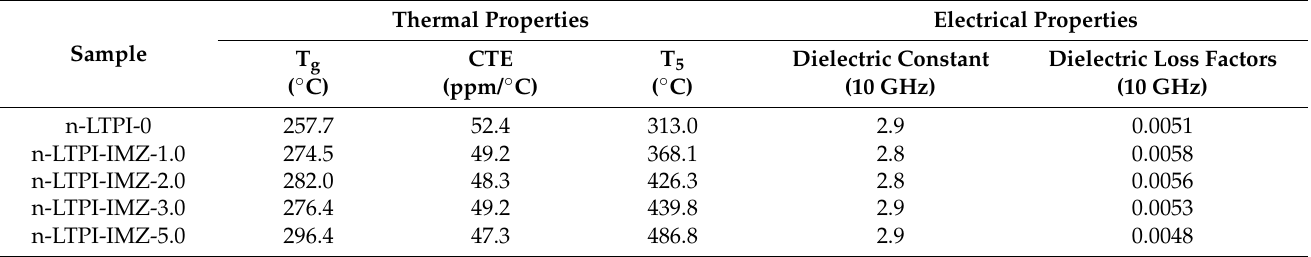
Figure 7. DMA stress–strain curves at 245 °C of the thermally cured n-LTPI films with different heteroaromatic bases. Table 4. Thermal and electrical properties of the thermally cured n-LTPI films at 230 ◦ C/2 h with different loadings of heteroaromatic